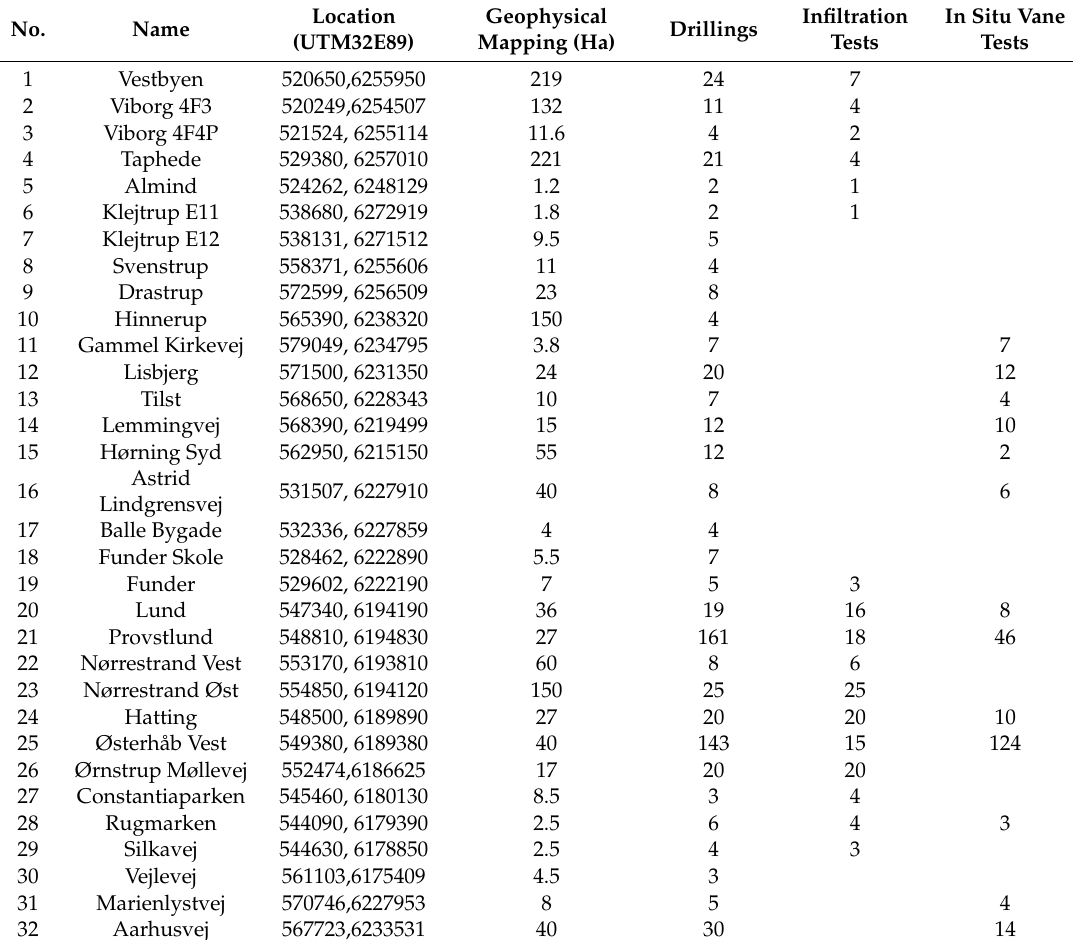
Table 1. Information on all the Investigated